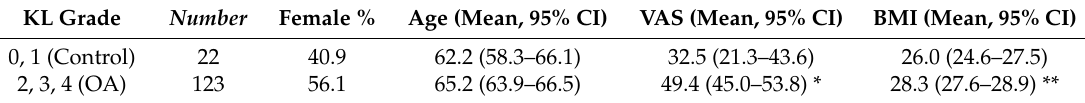
Table 2. Demographics of an osteoarthritis cohort. Mann-Whitney test was used to compare the difference of clinical parameters between the groups. * p < 0.05, compared to control group. ** p < 0.01, compared to control group. KL: Kellgren and Lawrence, VAS: visual analog scale, BMI: body mass index.